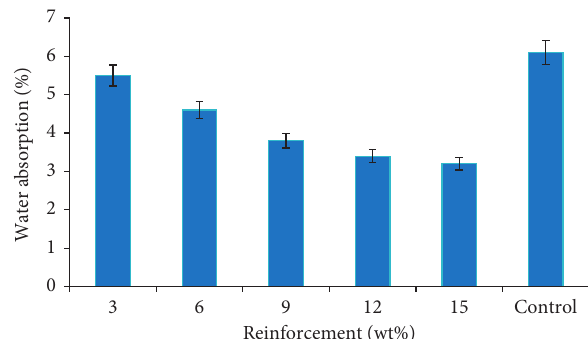
Figure 7: Variation in water absorption of the developed com- posites and the control.